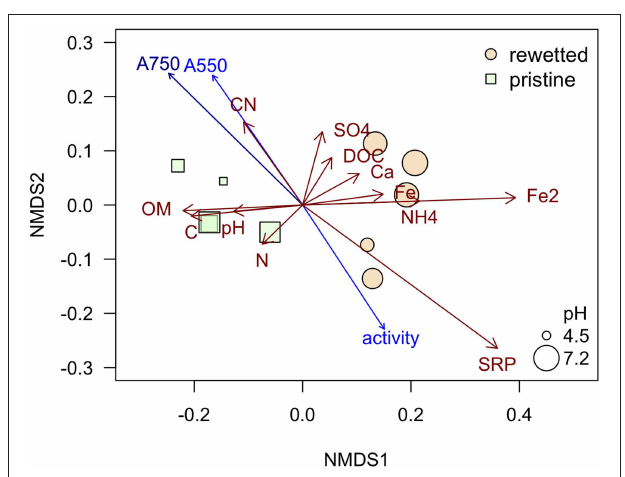
FIGURE 8 | NMDS plot based on the chemical characteristics of the peat and porewater analyses. The NMDS was run with defaults using function metaMDS of package vegan in R. Final stress was 0.059. Red arrows represent the included variables with vector lengths ≥ 0.1. Blue arrows are the post-hoc fitted variables on phenolic compounds and FDA, dark blue represents a variable that is significantly related to the ordination configuration with p <